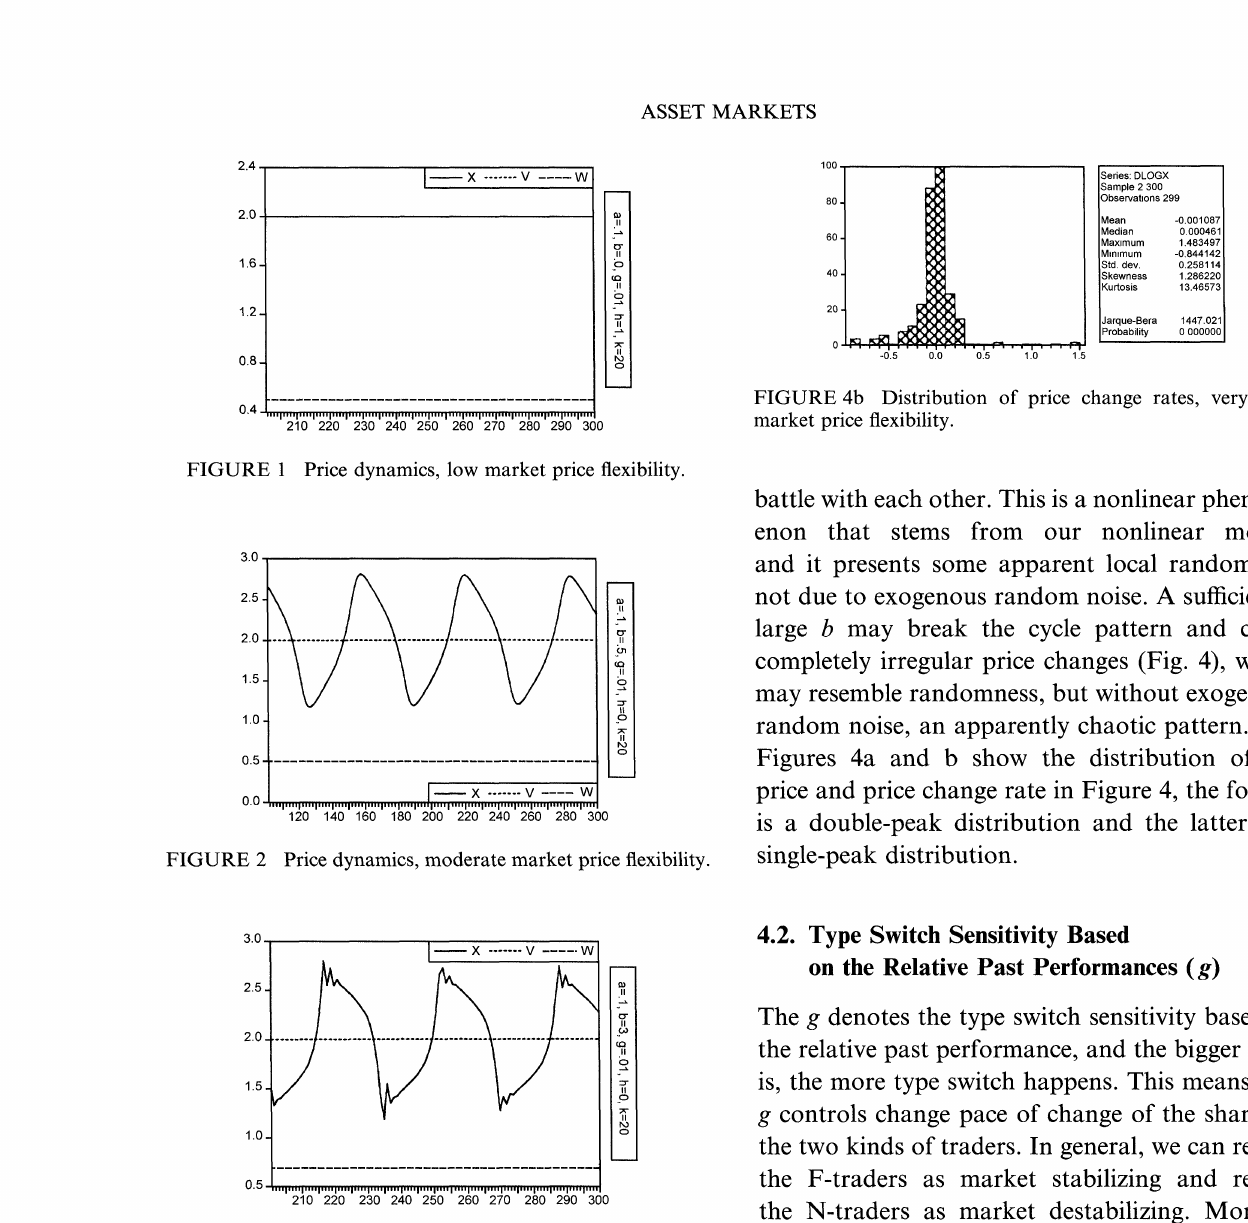
FIGURE 3 Price dynamics, moderately high market price flexibility.